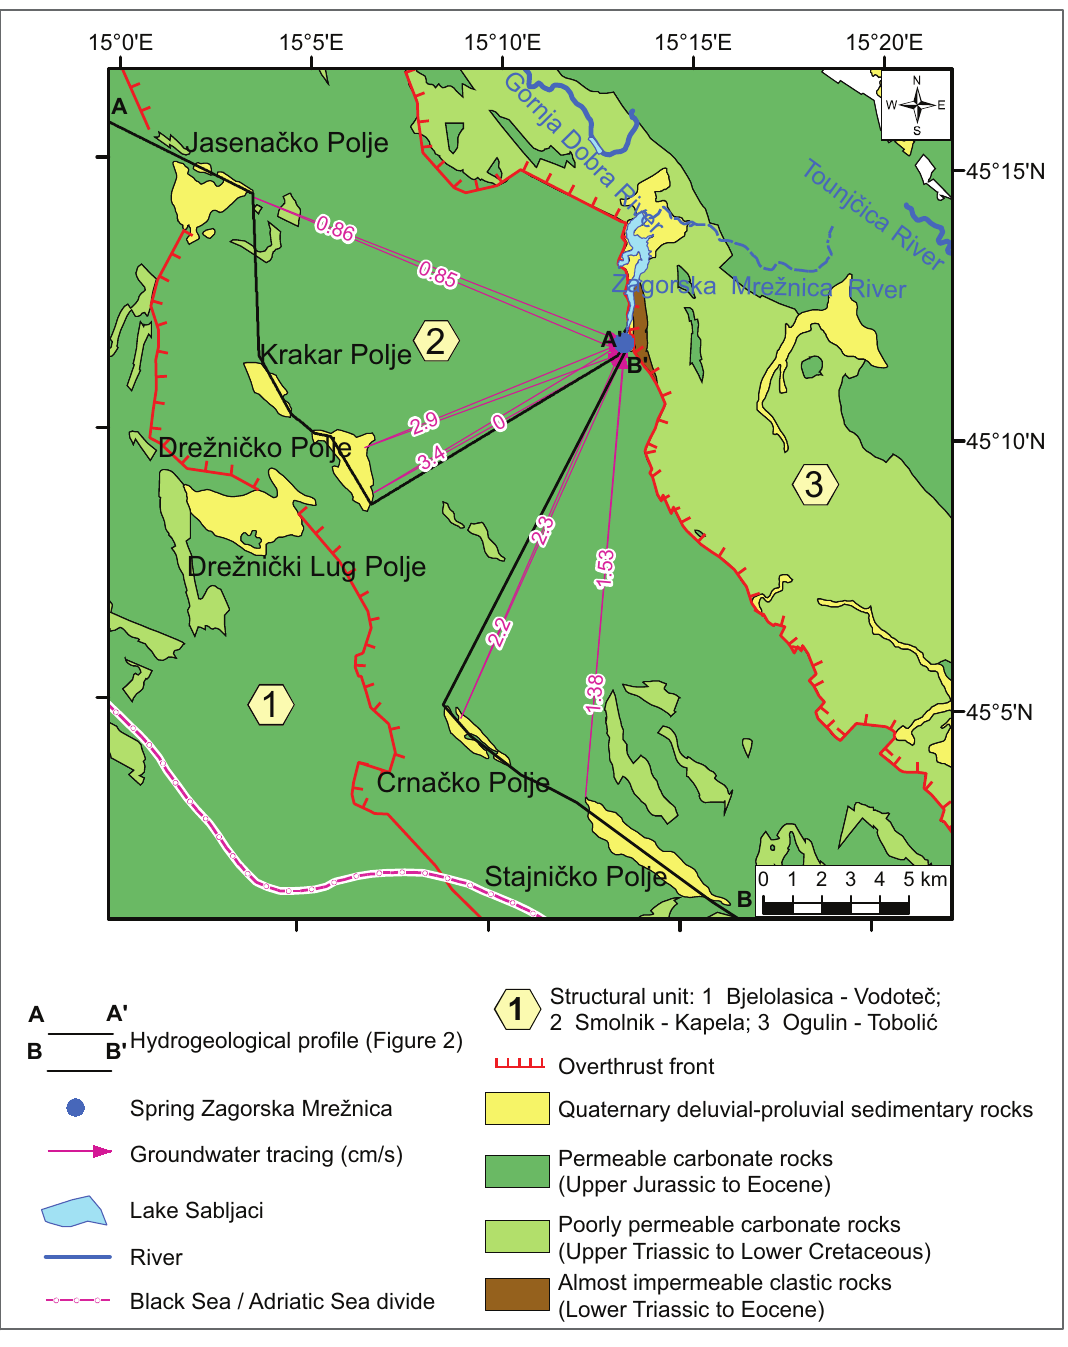
Figure 3. Schematized hydrogeological